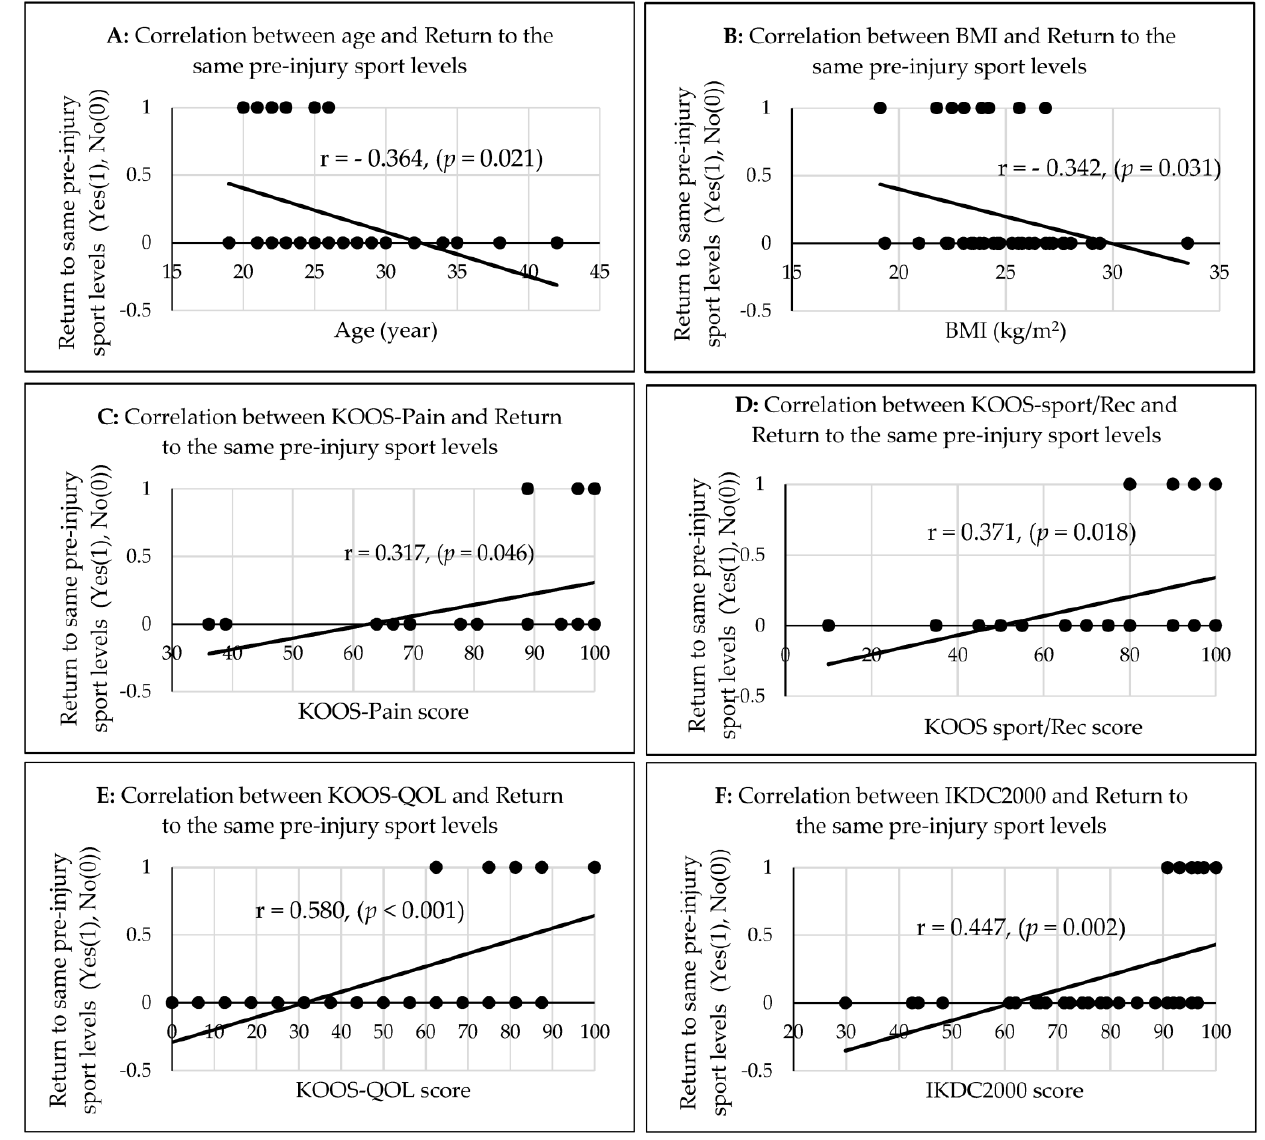
Figure 3. The correlations between the athletes' age ( A ), BMI ( B ), KOOS-Pain ( C ), KOOS-Sport/rec ( D ), KOOS-QOL ( E ), and IKDC2000 ( F ) with the return to the same pre-injury sport levels two years after ACLR.